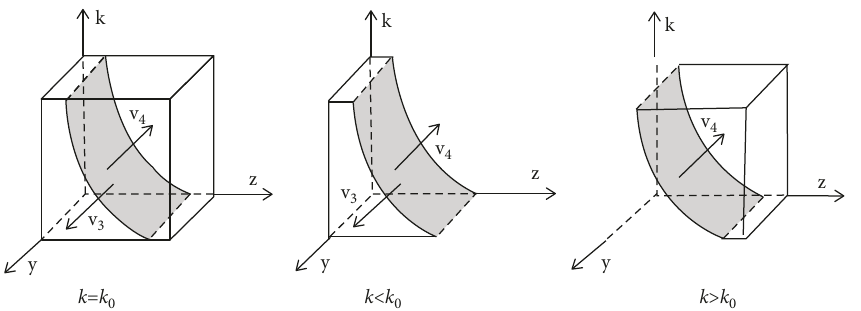
Figure 2: Phase diagram of creditors’ strategy